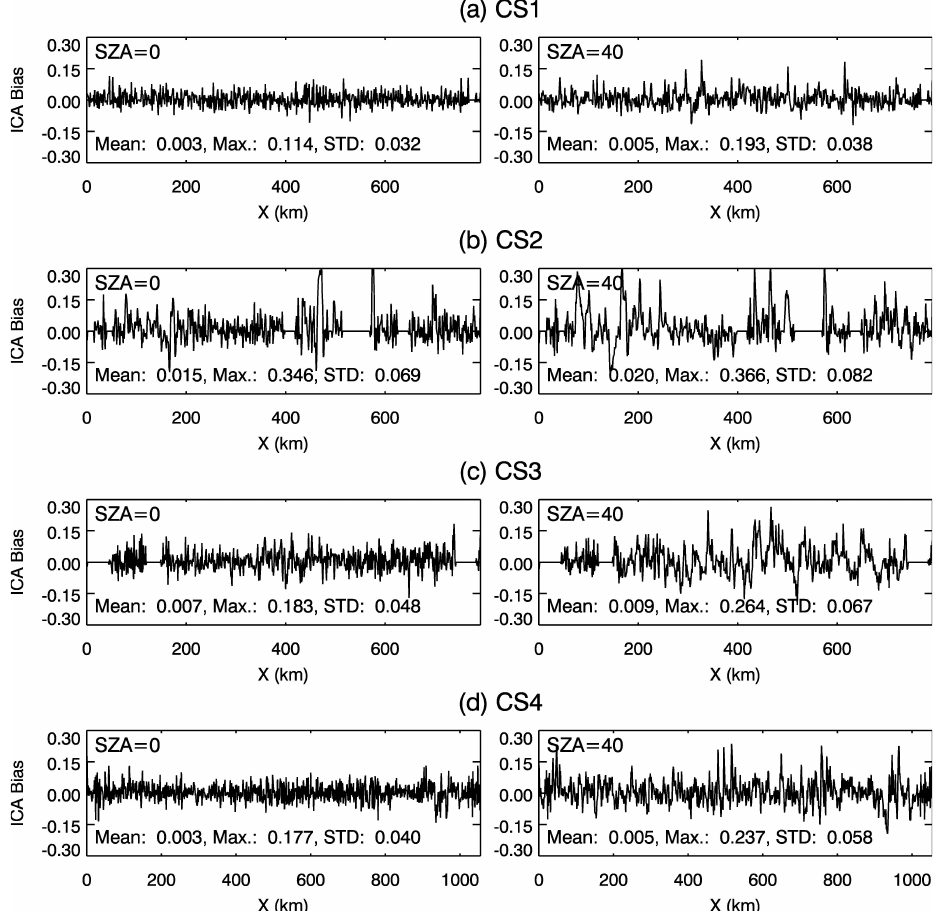
Fig. 6. ICA biases for (a) CS1, (b) CS2, (c) CS3, and (d) CS4. Two SZAs of 0 ◦ and 40 ◦ are considered for each